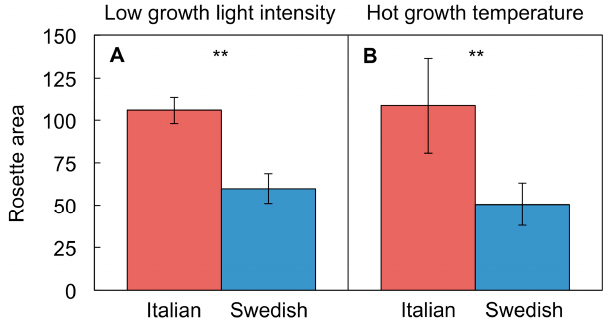
Figure 4. Rosette area (total light-exposed leaf area per plant) of Italian and Swedish ecotypes of A. thaliana grown ( A ) under low light intensity (100 µmol photons m − 2 ·s − 1 ) at a moderate leaf temperature (20 °C) and ( B ) at a hot leaf temperature (36 °C) under moderate light intensity (400 µmol photons m − 2 ·s − 1 ). Mean values ± standard deviations ( n = 3 to 4); significant differences ( t -test) indicated by asterisks—** = p < 0.01. Data from Stewart et al. ( A ) [86] and ( B ) [76]. The latter references also include images of plants grown under the various conditions.